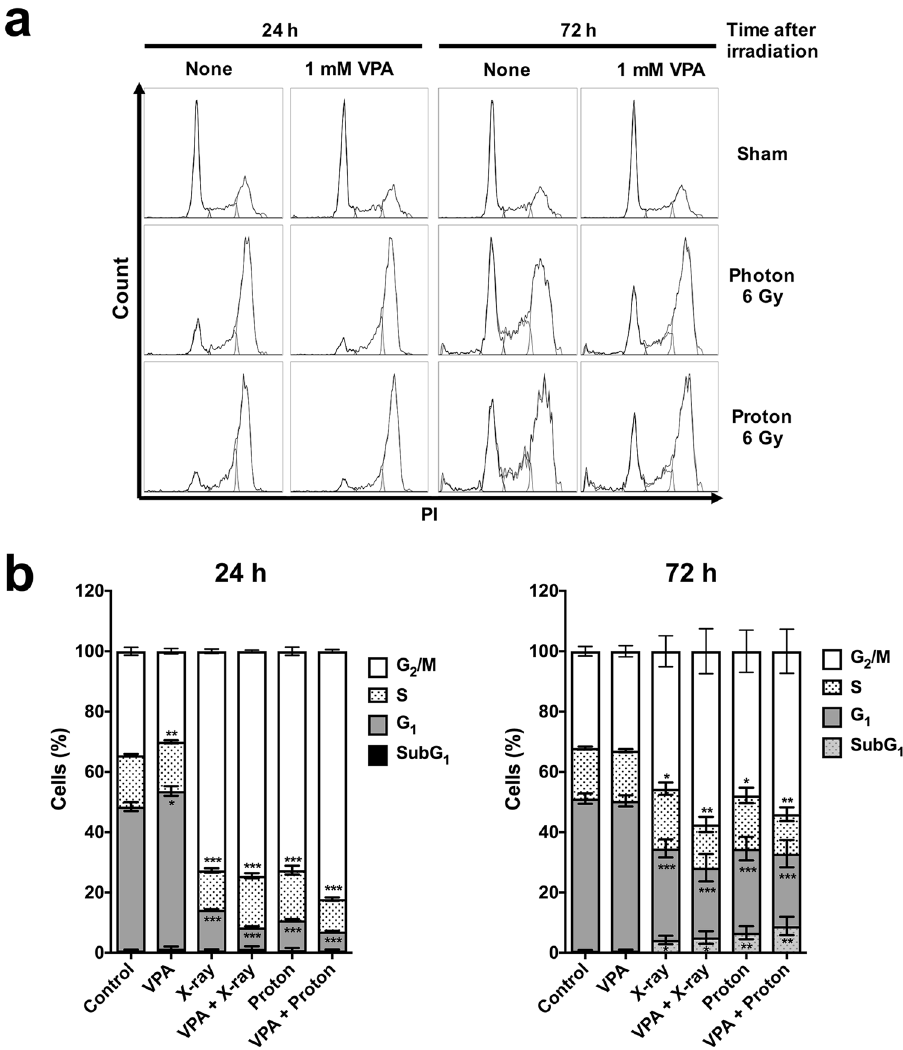
Figure 3. VPA attenuates radiation-induced G2/M arrest in Hep3B cells. ( a ) DNA histogram plots of Hep3B treated with or without 1 mM VPA at 24 h and 72 h after 6 Gy proton or photon irradiation. Cell cycle was assessed by propidium iodide staining and flow cytometry. ( b ) Distribution of each cell cycle shown as stacked column indicated attenuation of radiation-induced G2/M arrest by VPA. * p < 0.05, ** p < 0.01, *** p <